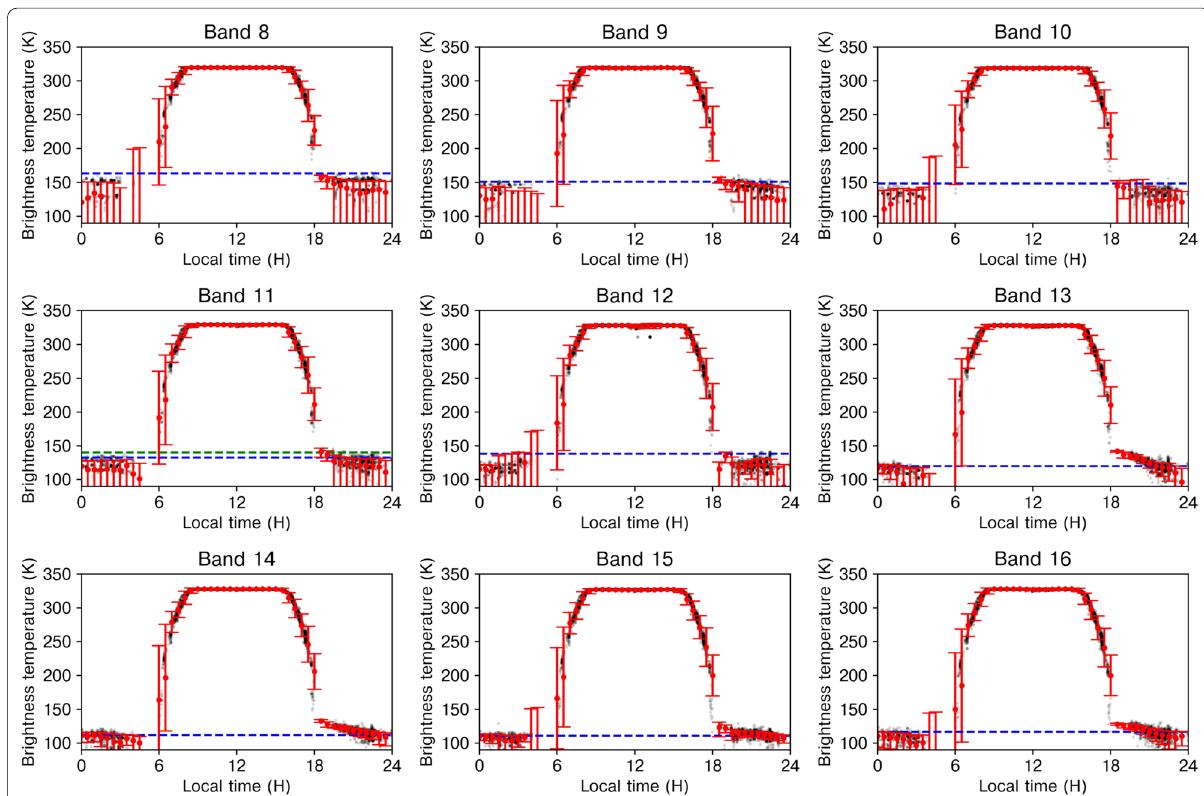
Fig. 4 The brightness temperature curves from HSD at bands 8–16. The gray dots show the brightness temperature in each pixel. The red points with error bars are the average values with standard deviations at every 0.5 H bin. The blue dashed lines indicate the noise level of AHI. The green dashed line in band 11 indicates the noise level of channel 5 of Diviner